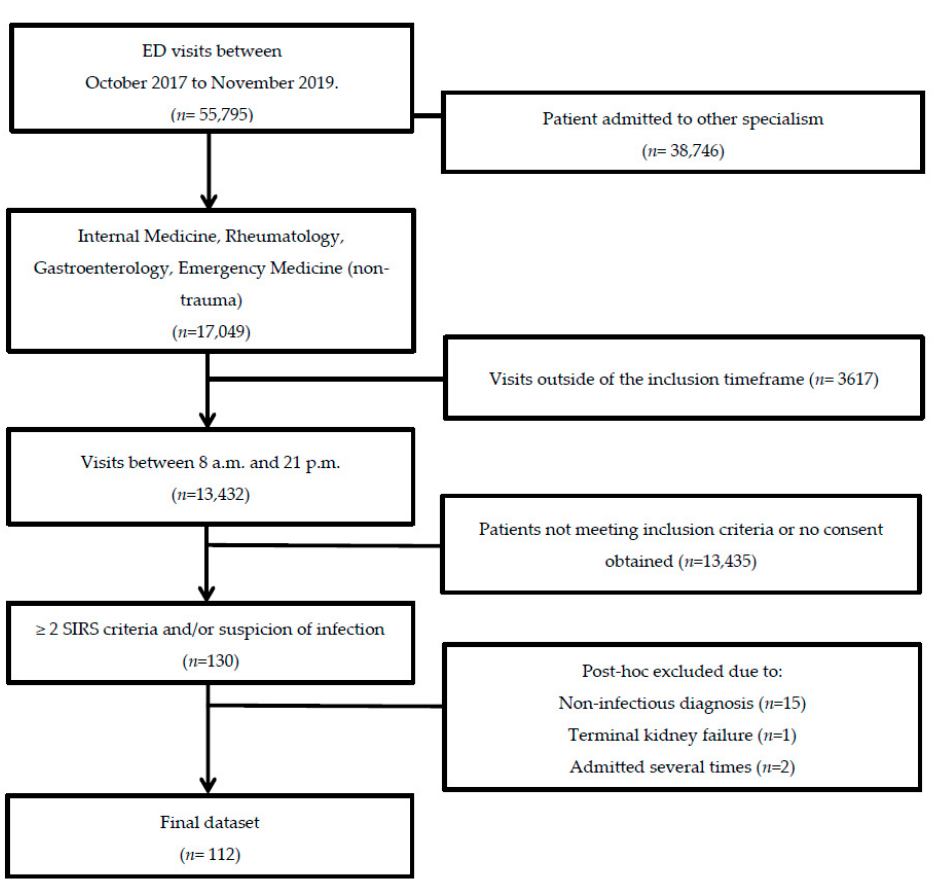
Figure 1. Flow chart of patient selection. Adult non-trauma patients who presented at the emergency department of the UMCG with a suspected infection between October 2017 and November 2019 were screened for inclusion.